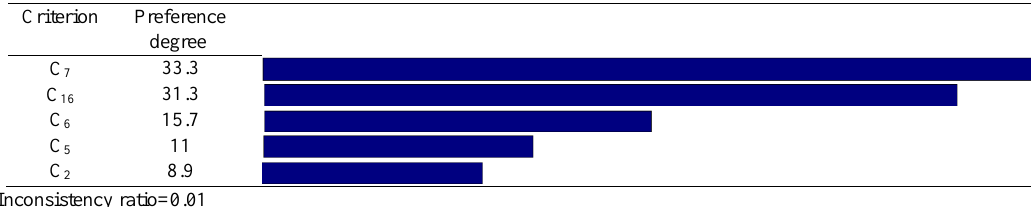
Table 12. Decision matrix of optimal combating-desertification alternatives according to group.